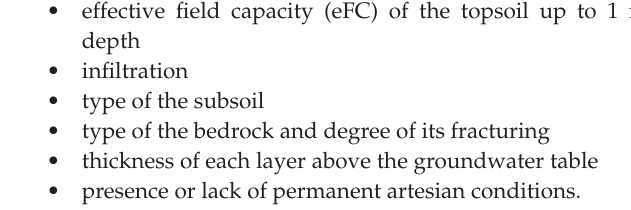
TABLE 1: Rating of the P-factor according to Goldscheider (2003). Score P Effectiveness of TS protective cover